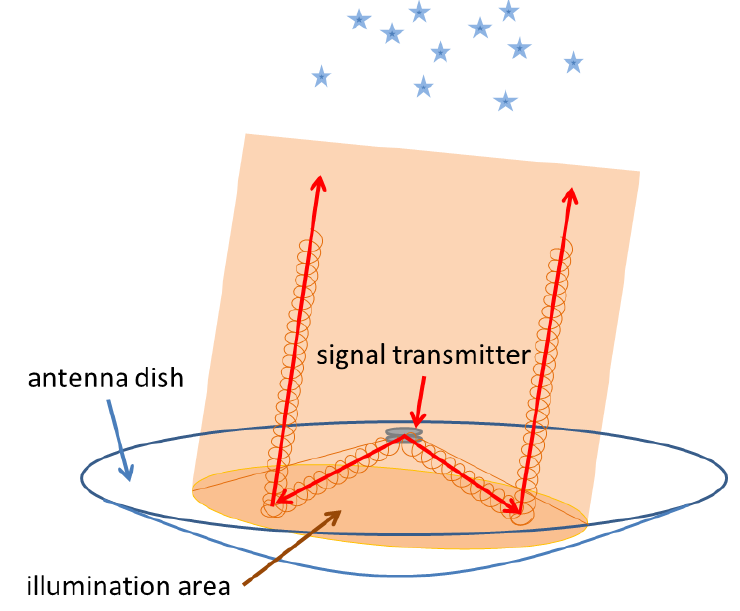
Figure 3. A diagram illustrating the FAST antenna dish and illumination area for receiving and transmitting signals.